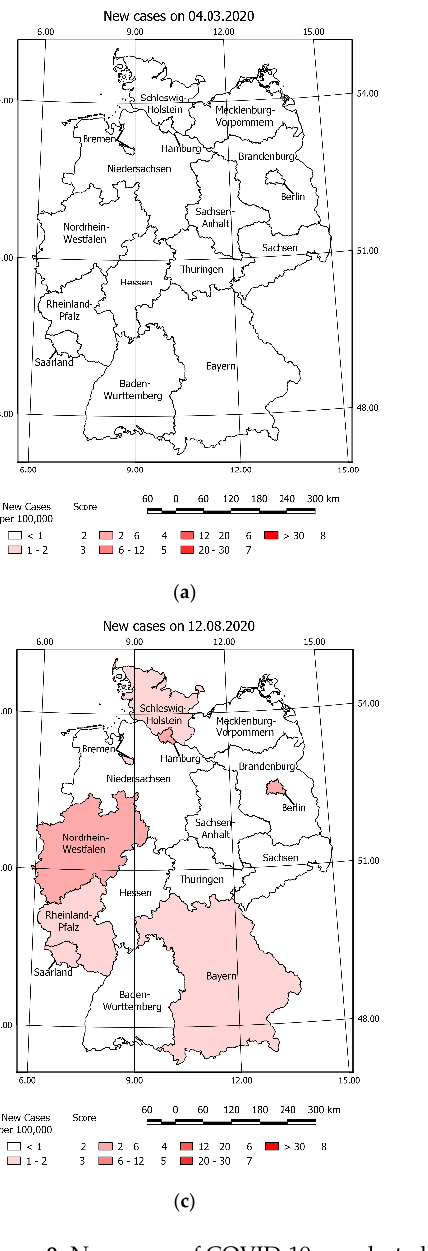
Figure 9. New cases of COVID-19 on selected days: ( a ) 4 March 2020 ( b ) 12 May 2020 ( c ) 12 August 2020 ( d ) 12 November 2020 remaining maps available in Figure